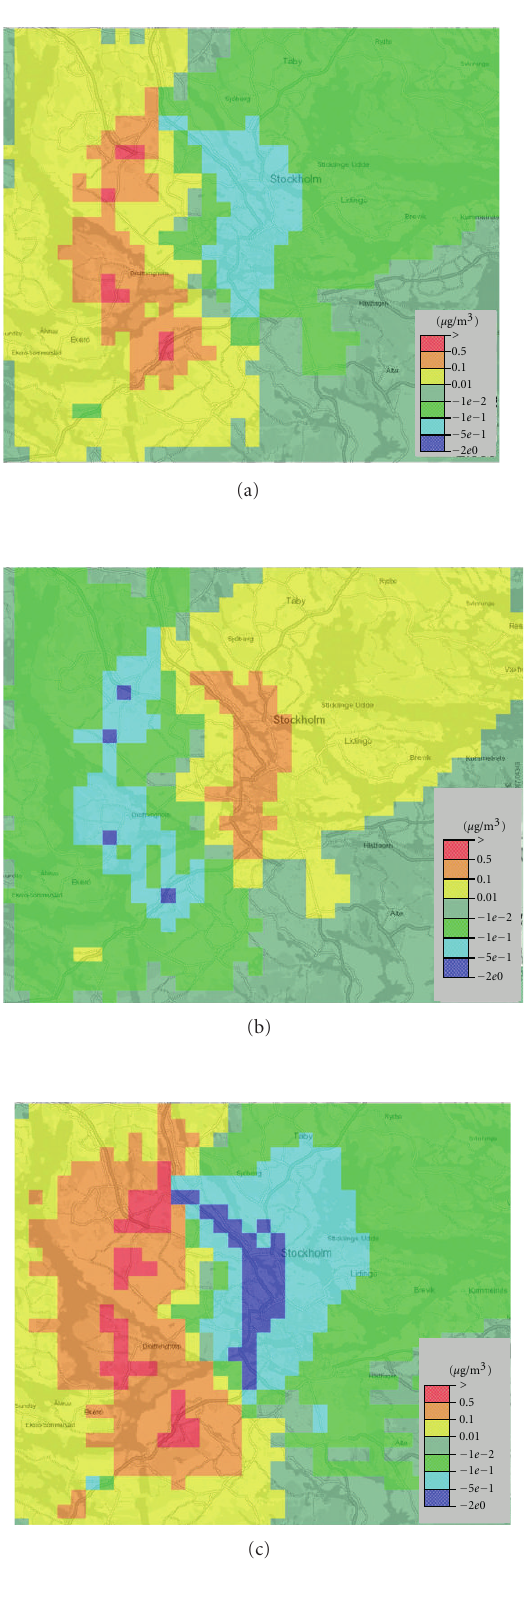
Figure 7: Di ff erences in simulated NO 2 (a), O 3 (b), and PM 10 (c) between the 2030 Road project and Reference average concentra- tions. Unit: µ gm − 3 .